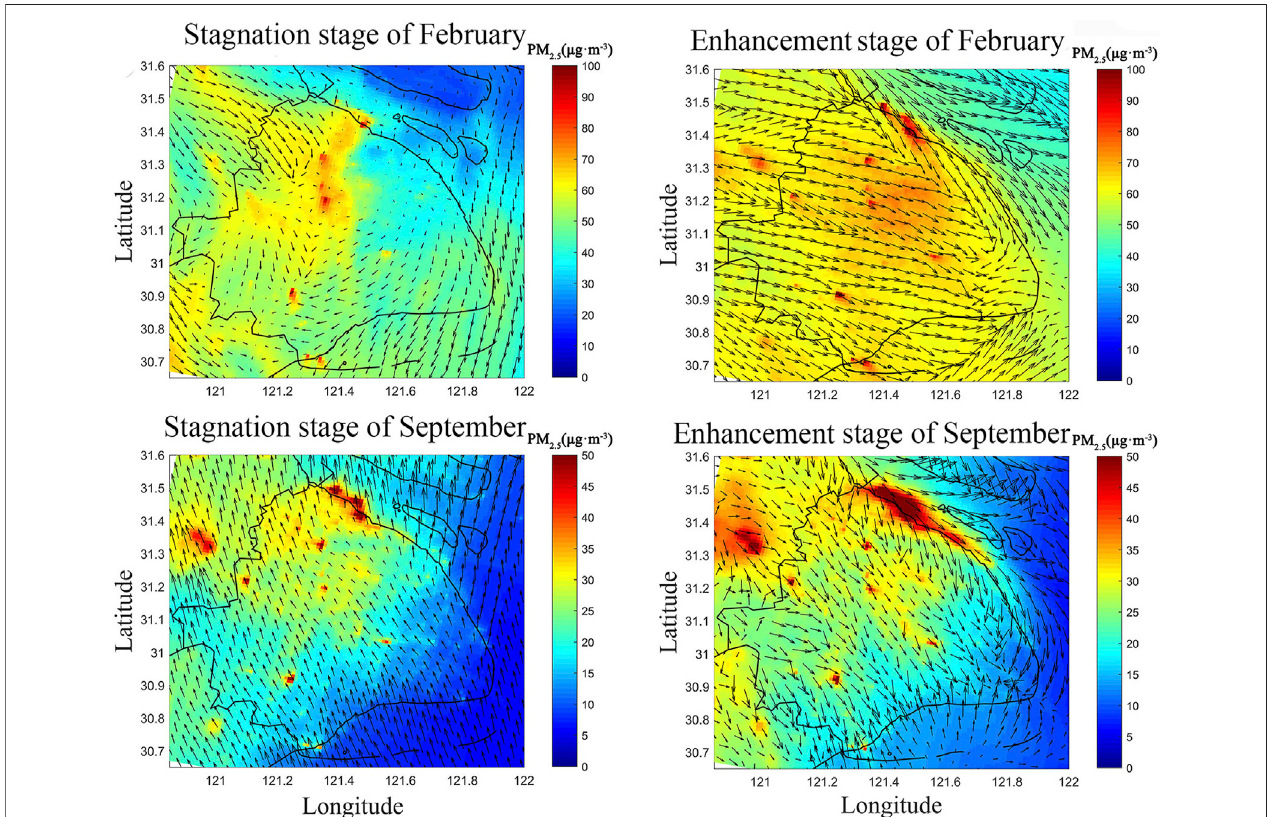
FIGURE 6 | Wind fi eld of Shanghai during stable weather in February and